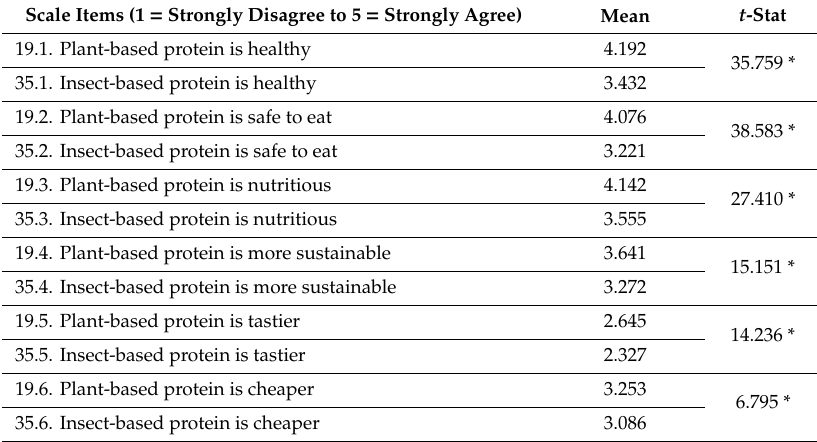
Table 6. Plant-Based vs. Insect-Based